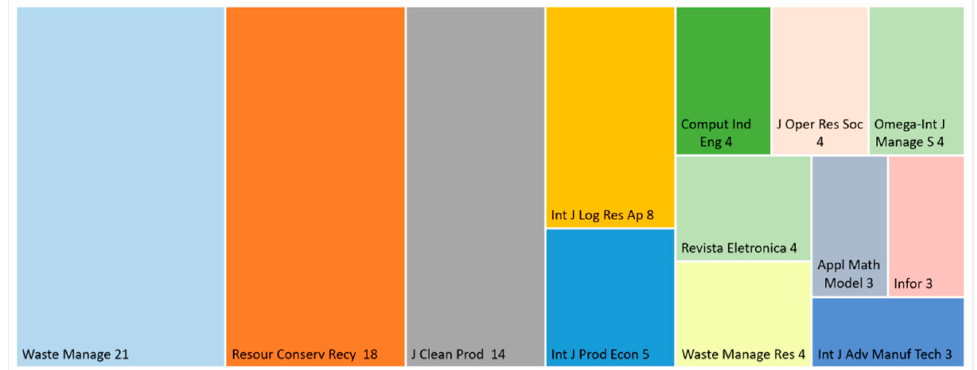
Figure 6. Distribution of waste collection related articles in journals, based on search in Web of Science.